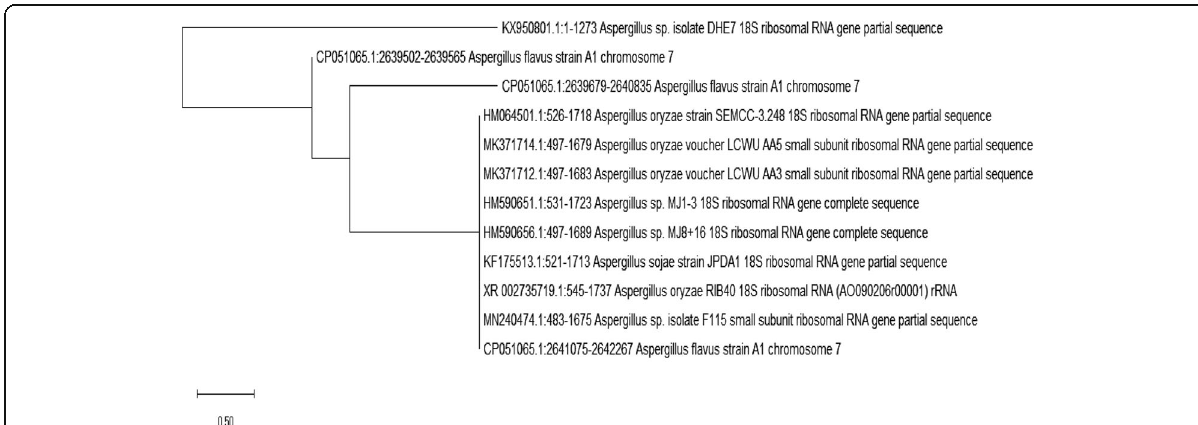
Fig. 1 Phylogenetic tree of Aspergillus sp. DHE7 based on the results of polymerase chain reaction (PCR)